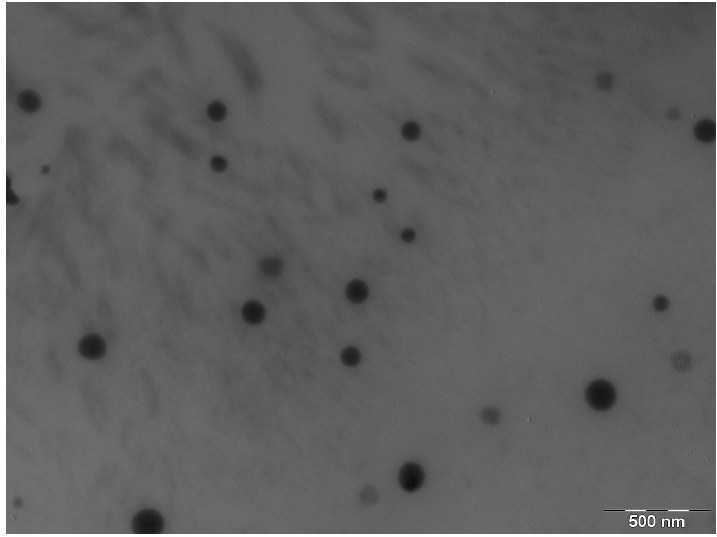
Figure 4. Transmission electron microscopy image of Apremilast microemulsion, magnification 40,000×.